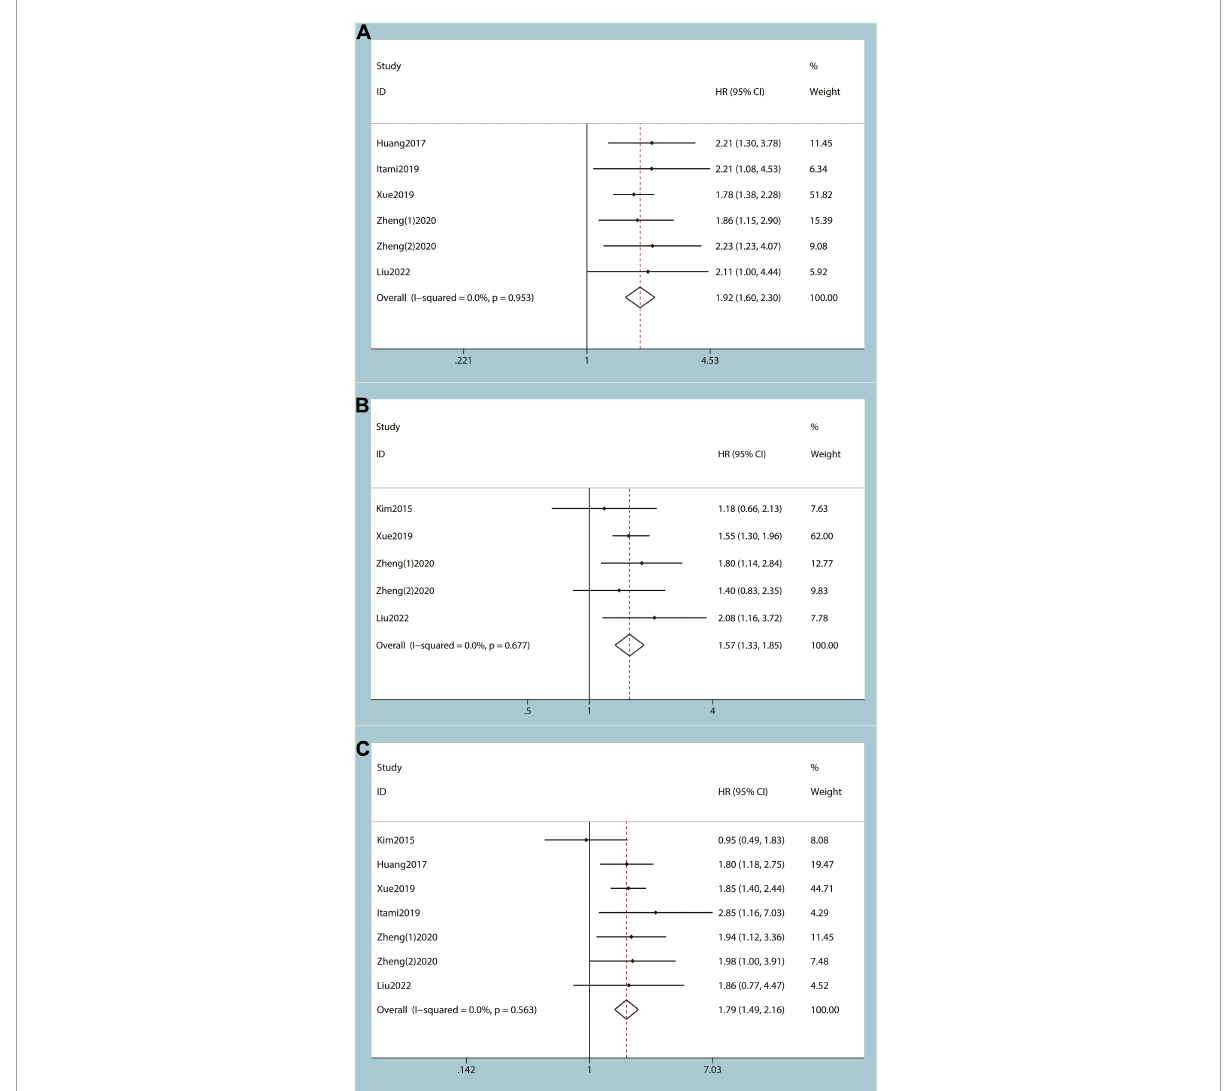
FIGURE2 Forest plot and meta-analysis. (A) Forest plot and meta-analysis of the relationship between over survival (OS) and prognostic nutritional index (PNI) score. (B) Forest plot and meta-analysis of the relationship between disease-free survival/recurrence-free survival/progression-free survival, and prognostic nutritional index score. (C) Forest plot and meta-analysis of the relationship between cancer-specific survival/disease-specific survival, and prognostic nutritional index score.